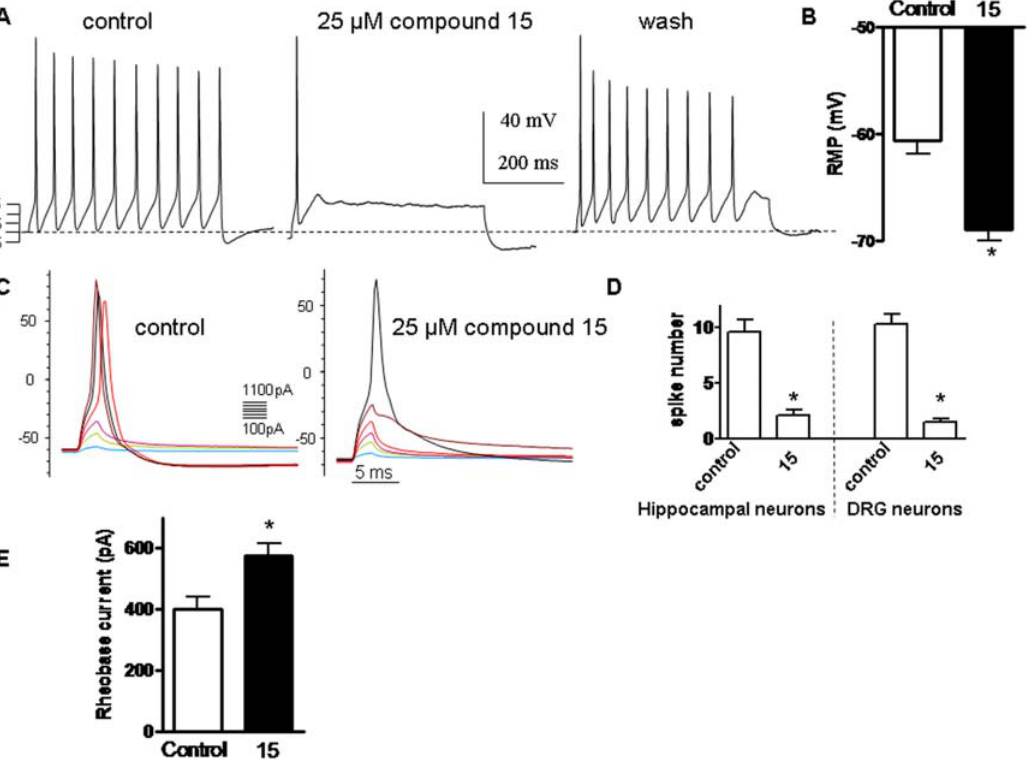
Figure 7. Compound 15 inhibits firing of hippocampal and peripheral DRG neurons. (A) Representative rat hippocampal spiking discharge, evoked by a squared depolarizing current pulse (100 pA for 400 msec) before (control), during exposure to 25 m M compound 15 and after washout (wash). (B) Resting membrane potential of DRG neurons before (control) and following exposure to 25 m M compound 15 (n=13; * p , 0.01). (C) Representative solitary spike evoked in DRG neurons by 2 ms squared depolarizing current pulses (100–1100 pA in 100 pA increments) in the absence (control) or presence of 25 m M compound 15. (D) Number of spikes evoked by injecting squared depolarizing current pulses (75–200 pA for 400 ms) in hippocampal and DRG neurons in the absence and presence of 25 m M compound 15 (n=8; * p , 0.01). (E) Rheobase current necessary to inject (2 ms) into DRG neurons to evoke a solitary spike in the absence and presence of 25 m M compound 15 (n=12; * p , 0.01).